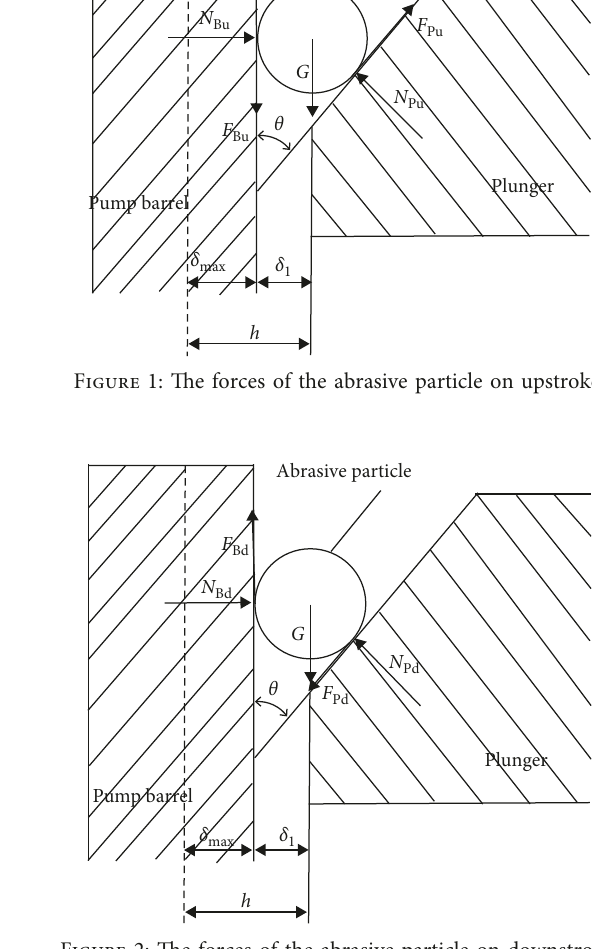
Figure 2: The forces of the abrasive particle on